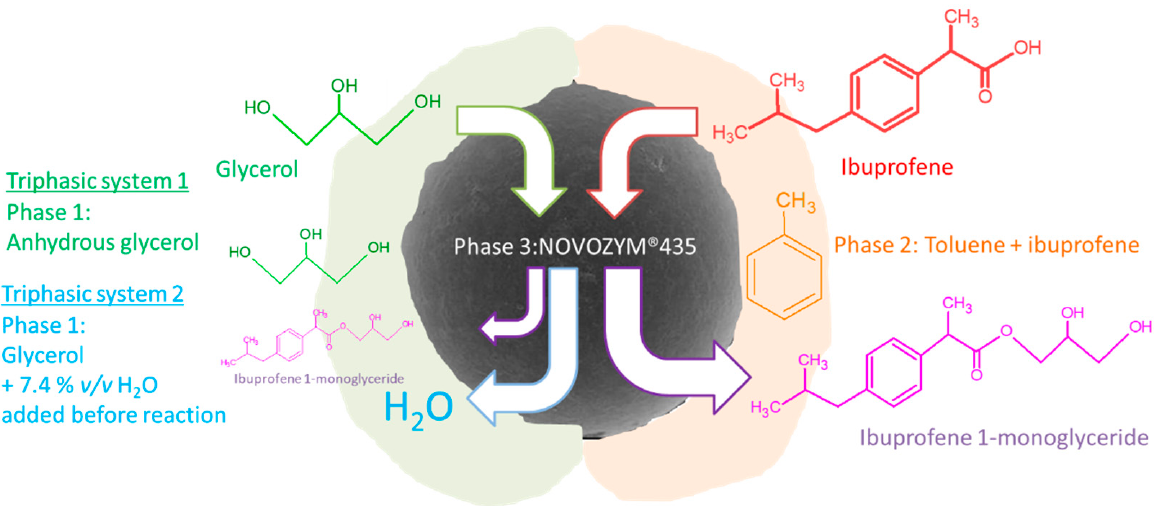
Figure 1. Reactions in triphasic L-L-S systems for the esterification of glycerol and ibuprofen with Novozym ® 435.